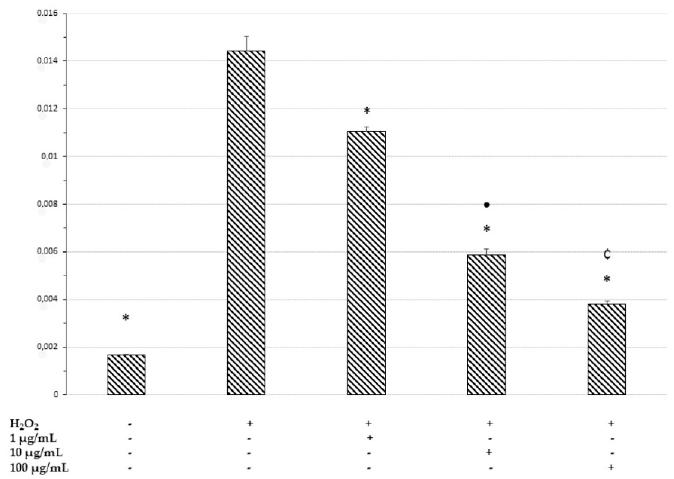
Figure 8. ELISA assay for PGE 2 secretion of cultures at 48 h. The secretion levels are reported as pg/mL. The data shown are the mean (±SD) ( n = 3). * p < 0.5 vs H 2 O 2, • p < 0.05 vs. 1 µg/mL+H 2 O 2 ; ¢ p < 0.05 vs. 10 µg/mL + H 2 O 2.